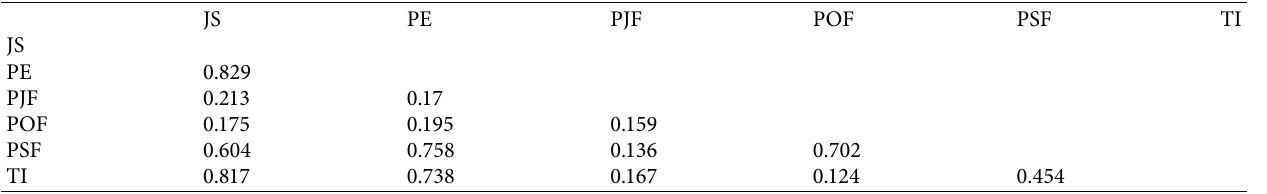
Table 4: Heterotrait-monotrait (HTMT) ratio.